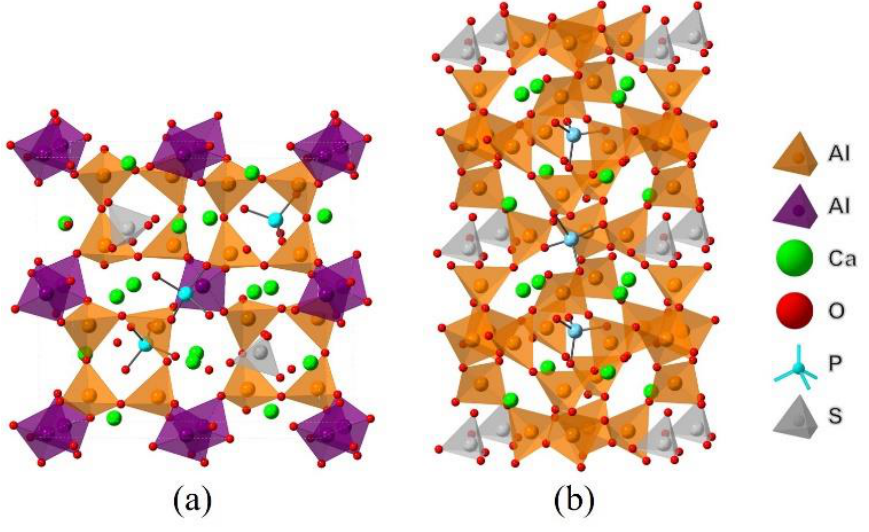
Figure 12. Models of co-substituting P-doped ye’elimite. ( a ) P@S&P@Al(ST), ( b ) P@S&P@Al(SS). To further examine the rationality of the co-substituting P-doped ye’elimite,